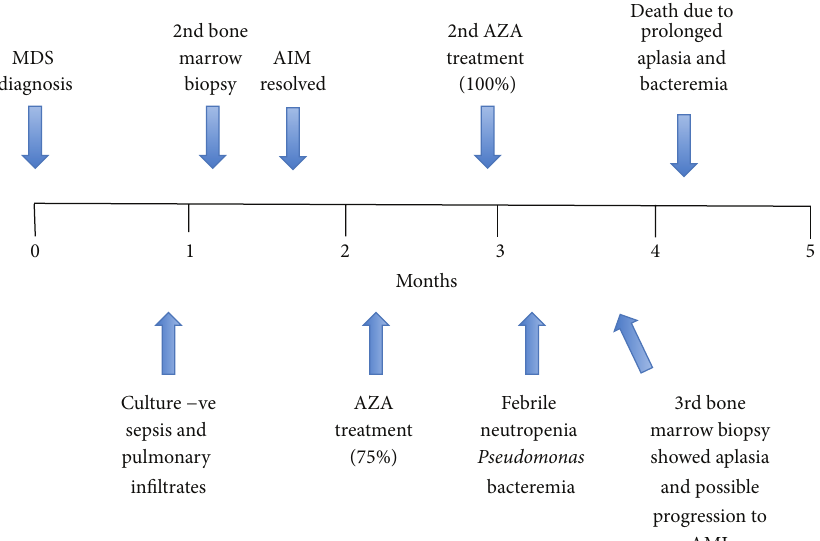
Figure1:ClinicalcourseofapatientpresentingwithhigherIPSSriskMDSinthecontextofwell-controlledHIVinfection.AIM:autoimmune manifestations; AML: acute myeloid leukemia; AZA: azacitidine; IPSS: International Prognostic Scoring System; MDS: myelodysplastic